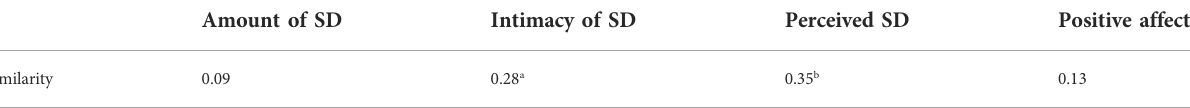
TABLE 6 Pearson ’ s correlation results of the feeling of similarity with self-disclosure (SD) and positive affect change. Amount of